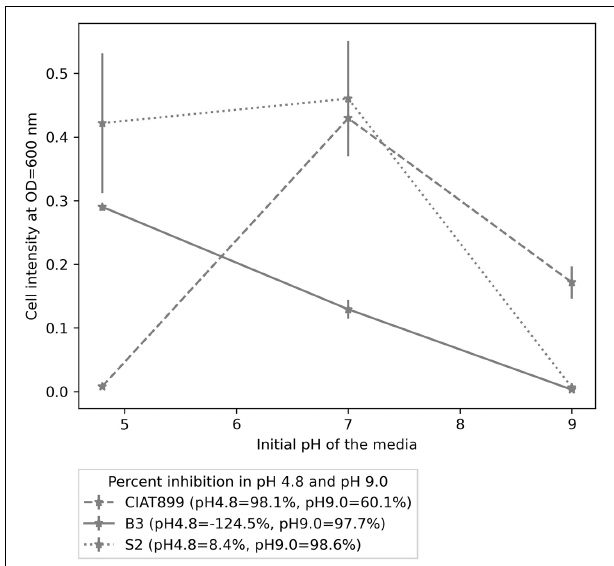
FIGURE 4 | The growth pattern of isolates B3, S2, and CIAT899 in yeast extract mannitol broth (YMB), in which the pH was maintained 4.8, 7.0, and 9.0. The figure legend contains percent inhibition values of the isolates at pH 4.8 and 9.0 when samples at pH 7.0 were used as the reference.